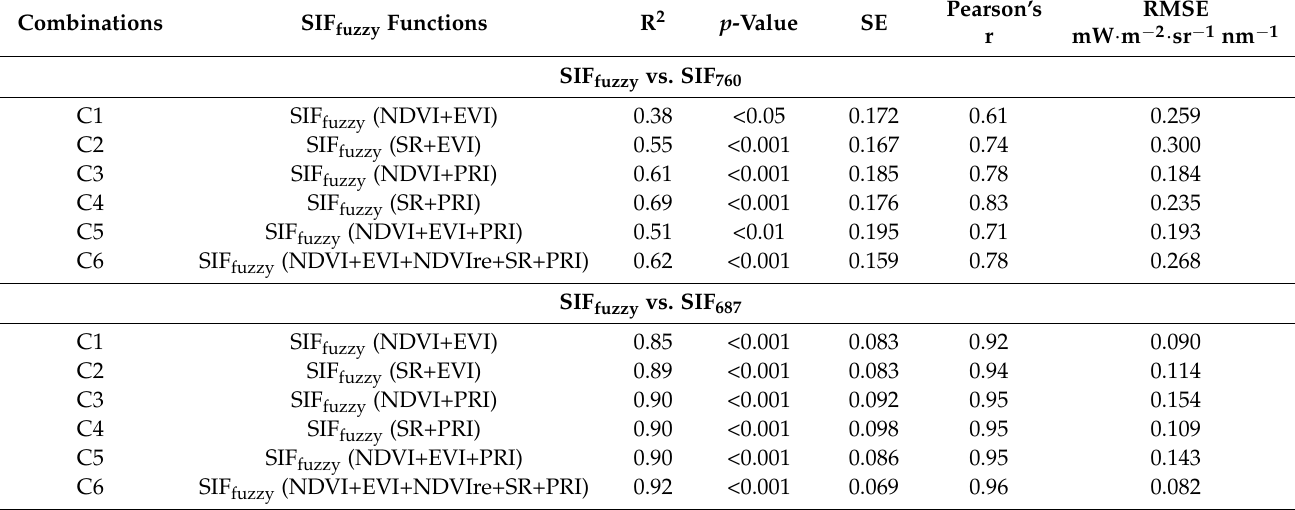
Table 4. Summary of the statistics (R 2 —coefficient of determination, p -value, SE—standard error, R—correlation coefficient and RMSE—root mean square error) of linear regressions between SIF fuzzy vs. SIF 760 and SIF fuzzy vs. SIF 687 . The statistical operational outputs were derived based on 19 ROIs representing vegetation groups of the forest, grassland and peatland. Combinations SIF fuzzy Functions R